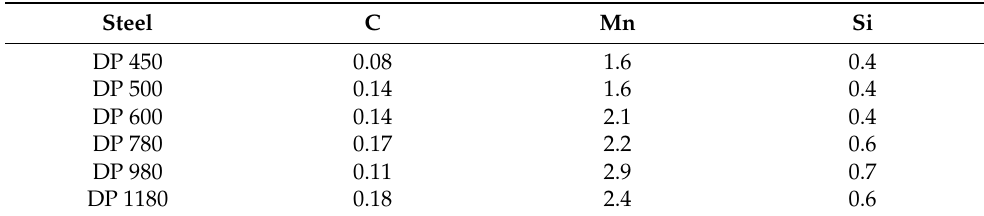
Table 8. Chemical composition of dual-phase steels, wt%. Data from [37].